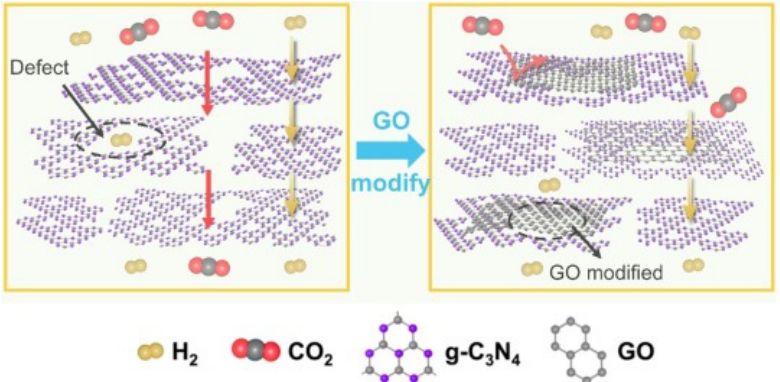
Figure 19. Illustration of gas molecular transport through the GO-modified g-C 3 N 4 nanosheets membranes, scheme taken from [159].